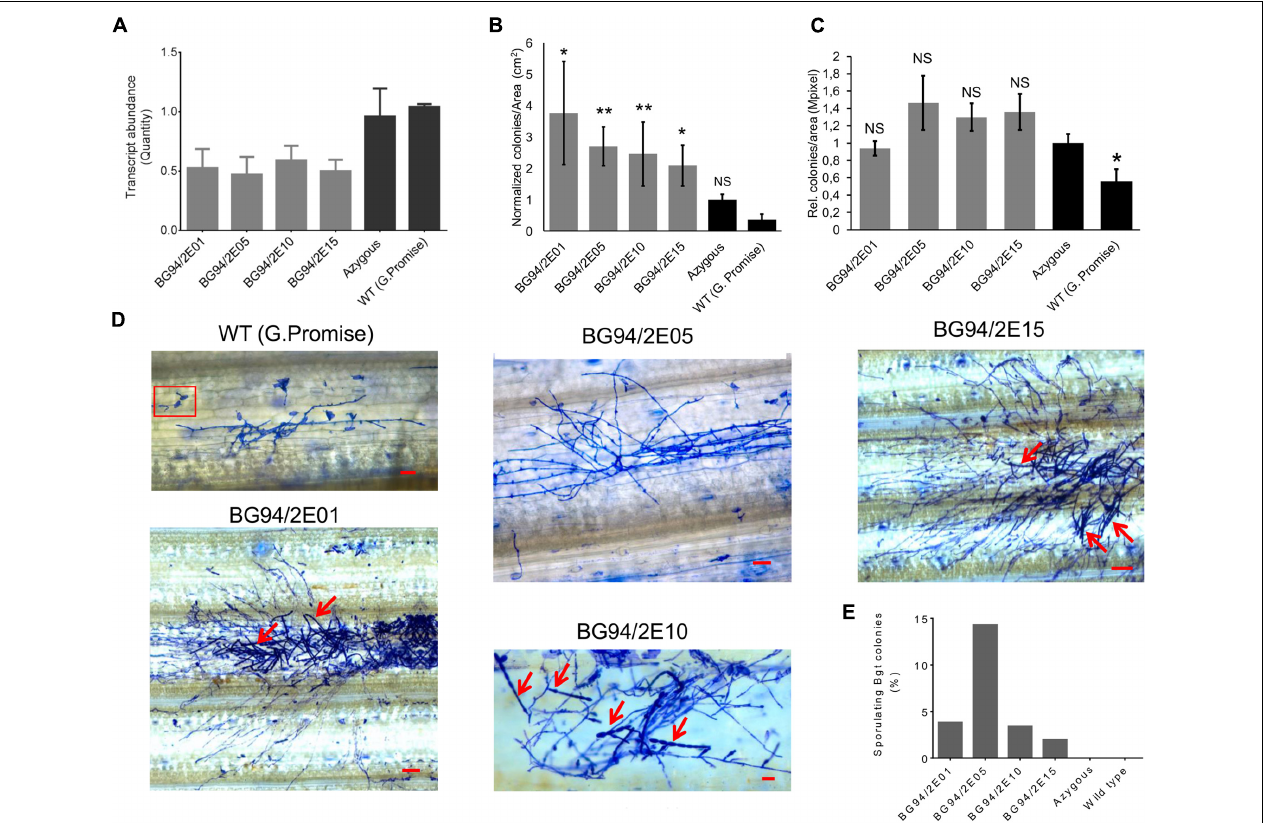
FIGURE 4 | Phenotype of RNAi transgenic T1 plants of barley with reduced HvLEMK1 expression. (A) RT-qPCR of HvLEMK1 in selected T1 families. Mean values ± SE from two independent experiments (batches of plants sown on different dates, non-inoculated) are shown. (B) Reduced non-host resistance of transgenic events against Bgt . Mean values ± SE of manual microscopic colony counting 7 d.a.i. from three independent inoculation experiments, normalized to the mean value of the azygous control group, are shown. Statistical significance are indicated by asterisks. ∗ p < 0.05, ∗∗ p < 0.005. n, total number of analyzed plants per event. (C) No change in quantitative host resistance against Bgh of most of the T1 families shown in (A) . Mean values ± SE of automated microscopic colony counting by the HyphArea software at 48 h after inoculation (two independent inoculation experiments) are shown. Asterisk indicates statistical significance. ∗ p < 0.05; n, total number of analyzed plants per T1 family; NS, not-significant. (D) Examples of enhanced colony growth including sporulation (red arrows) of Bgt on leaves of HvLEMK1 -silenced T1 plants. Panel “WT (Golden Promise)” shows examples of frequently failed penetration (inside red frame) plus one of the rarely observed, non-sporulation Bgt micro-colonies. Scale bars = 50 µ m. (E) Percentage of sporulating Bgt colonies (mean values from two independent